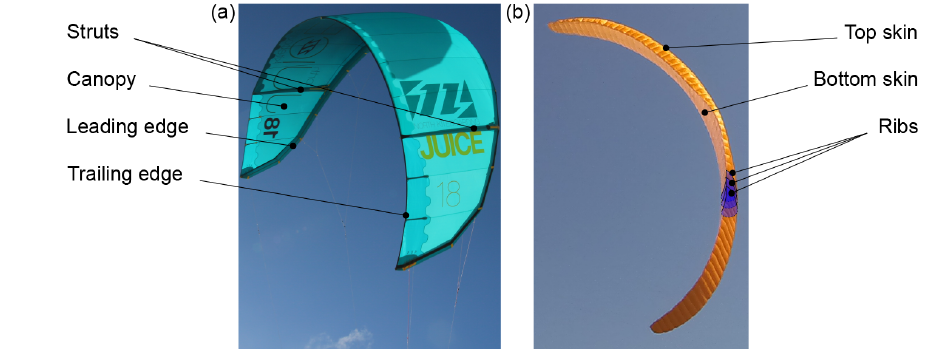
Figure 1. Leading edge inflatable (LEI) tube kite (a) and ram air wing (b)